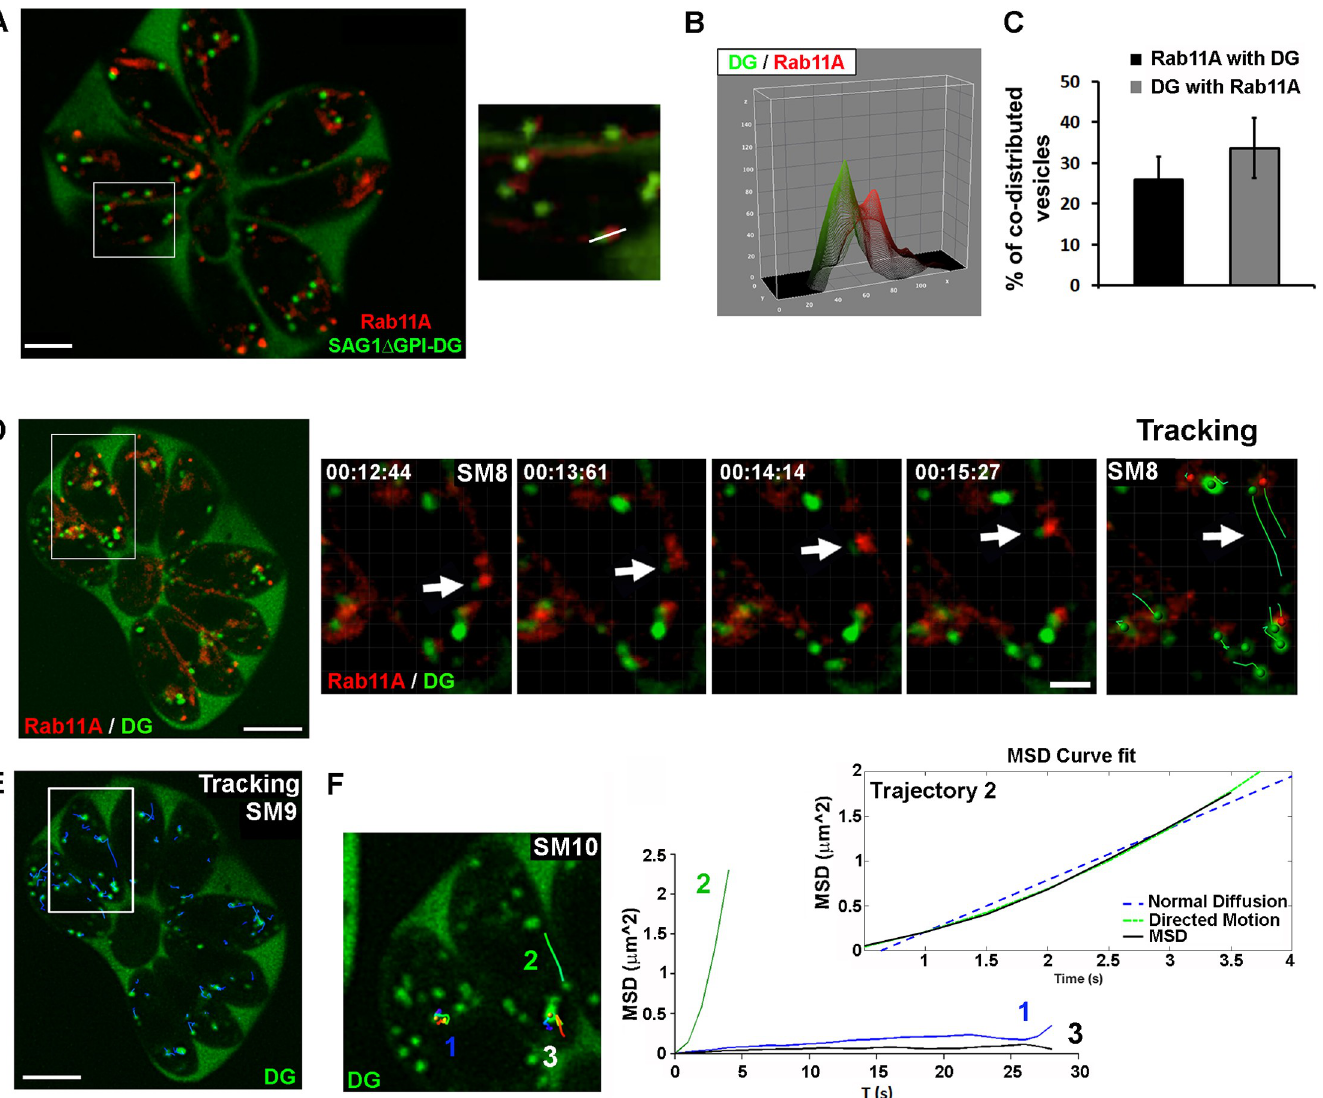
Fig 2. A- Image extracted from a time-lapse acquisition illustrating the release of SAG Δ GPI protein (green) into the vacuolar space of mcherryRab11A-WT and SAG Δ GPI-GFP expressing parasites, as well as the co-distribution in the parasite cytosol of SAG Δ GPI-GFP positive DG (green) and mcherryRab11A-WT positive vesicles (red). The right insert shows a zoom of the region indicated by a white frame in the full vacuole. Bar: 2 μ m. B - Fluorescence intensity profiles plotted over the distance of the GFP and mcherry signals along the line indicated in A (insert). C- Percentage of co-distribution between the total population of SAG Δ GPI-GFP-positive DGs and mcherryRab11A-WT-positive vesicles of a given vacuole averaged over 5 consecutive time points (n = 10 vacuoles). Data show mean ± SD. D- Sequences of images extracted from S8 Movie (region indicated by a white fame in the full vacuole) showing the joint motion of a Rab11A-positive vesicle (red) and a SAG Δ GPI- positive DG (green) along the parasite cortex, as illustrated by their tracking (S8B Movie). Time is indicated in seconds. E- Automated tracking of all DG trajectories within the vacuole (S9 Movie). F- Three trajectories (1, 2, 3) (S10 Movie) in the region indicated by a white frame in E - were analyzed by plotting the Mean Square Displacement (MSD) over Δ T (s) using the Imaris software. Trajectory N˚2 (black line) corresponding to the track shown in -D (S8 Movie) fitted a mathematical model of “directed” motion (green line) defined by the equation MSD = 4Dt+v 2 t 2 while trajectories 1 and 3 display confined motions. https://doi.org/10.1371/journal.ppat.1008106.g002 accumulation of DGs observed at the altered interface between the two segregating daughter cells accounted for a local quasi static behavior as illustrated by their confined trajectories (Fig 3F: trajectories 2, 3 and SM11). Rare longer trajectories could be detected along the cortex of the parasites (such as illustrated for trajectory 1), however they never fitted, with good proba- bility, a model of directed motion. In agreement, analysis of cortical DG trajectories in